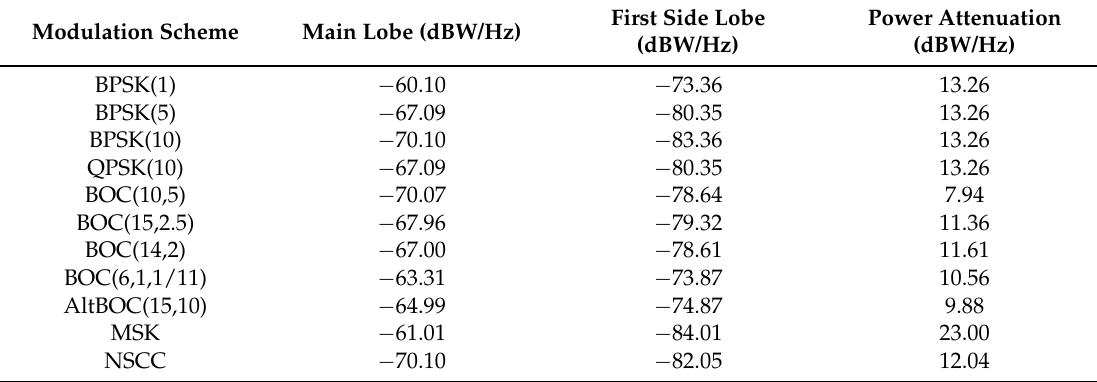
Table 1. The relative power attenuations between the first side lobe and the main